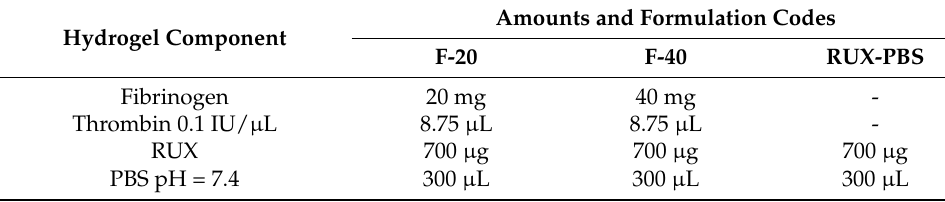
Table 1. Composition of RUX-loaded fibrin hydrogel